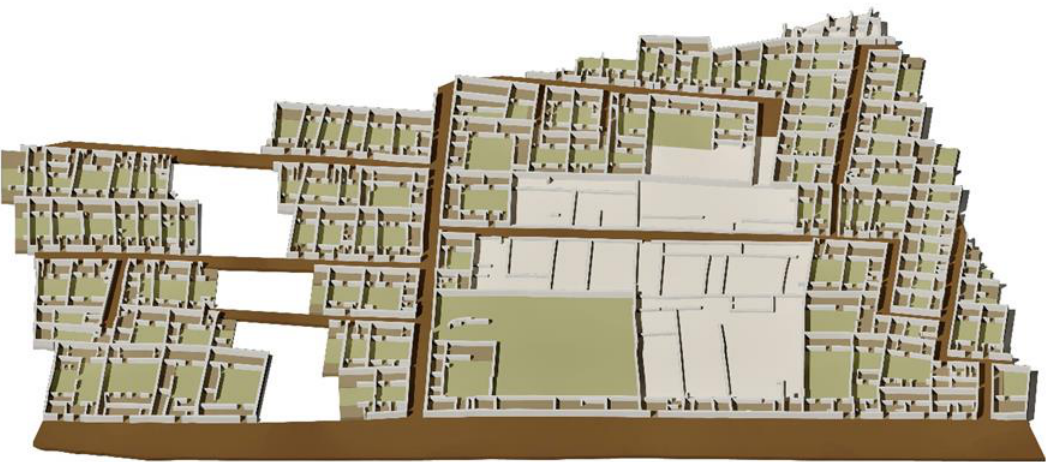
Figure 30. Three-dimensional (3D) reconstruction of the houses in arrabal Huerta de Santa Isabel, Córdoba (Ángela Mª. Aparicio Ledesma).